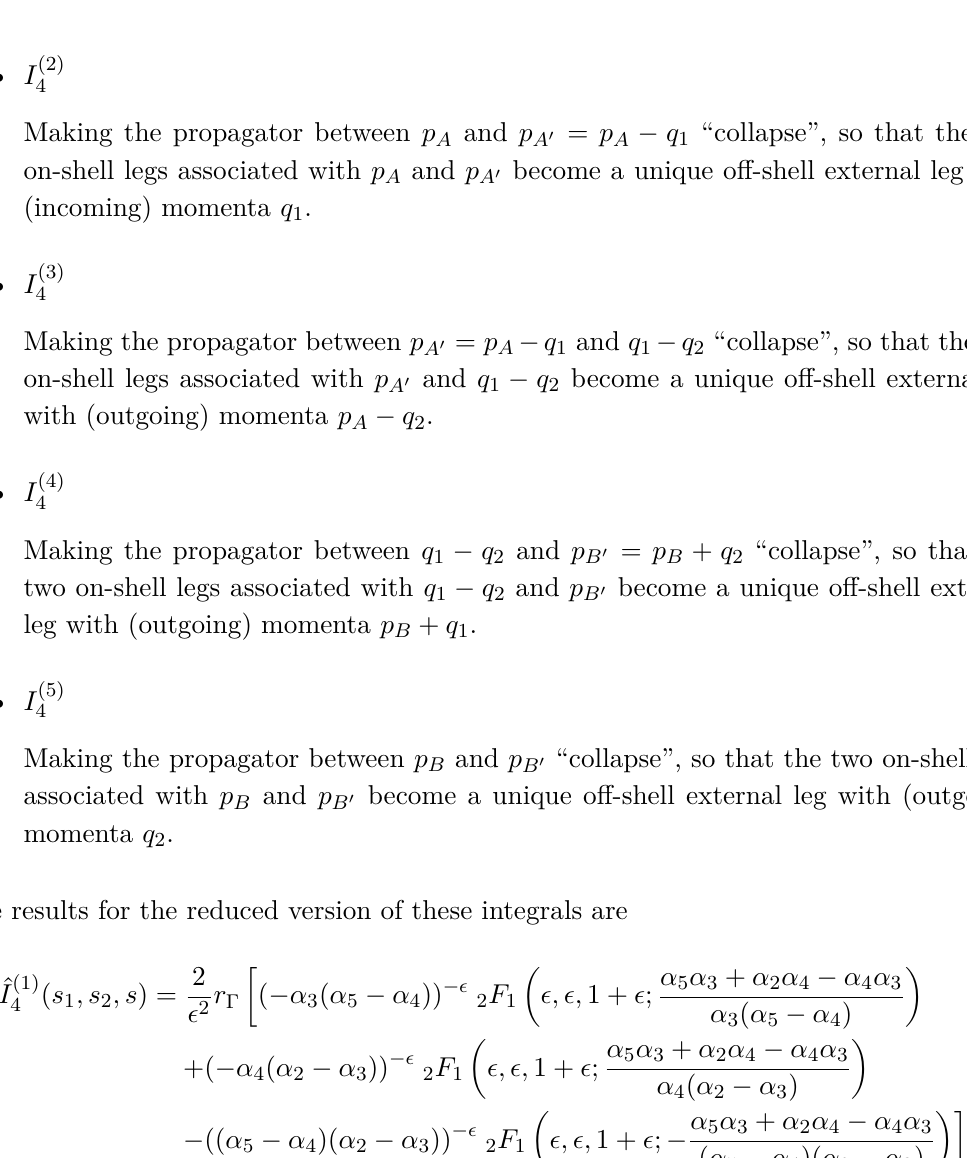
Figure 1 . Schematic representation of the pentagonal integral. The arrows denote the direction of the